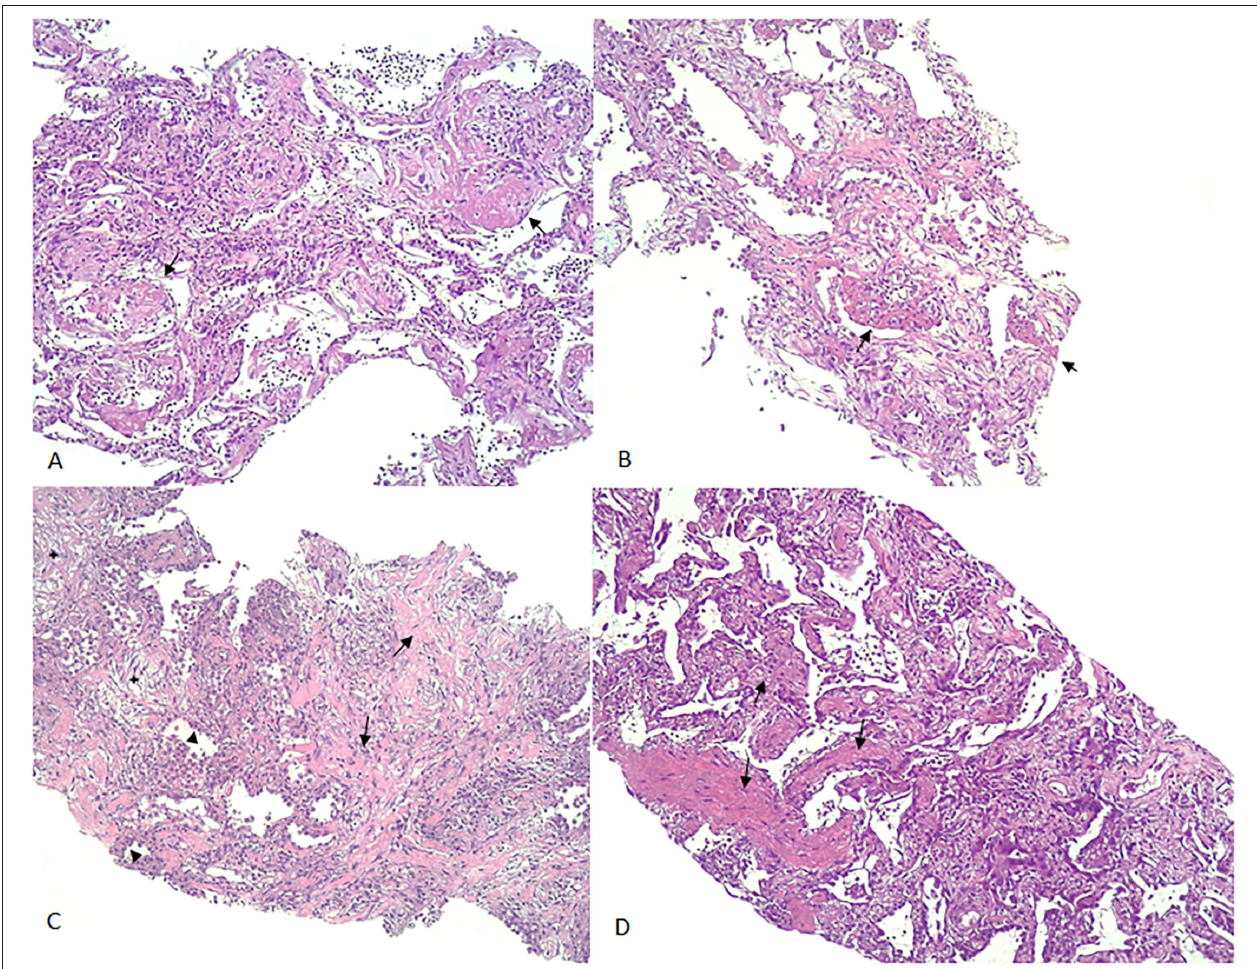
FIGURE 2 | Examples of CNB. (A) : AFOP-like DAD: (arrows: deposition of fibrin plugs filling the alveolar space); (B) : AFOP-like organizing DAD (arrows: fibrin plugs deposited in the alveoli and focal organization changes in the interstitium); (C) : AFOP-like fibrotic DAD [focal organizational changes (star), interstitial deposition of collagen (arrow) accompanied by pneumocyte type II hyperplasia (arrowhead)]. (D) : Fibrotic DAD (arrows: thickening of the alveolar septa with mature collagen deposition in the interstitium). CNB, core needle biopsy; DAD, diffuse alveolar damage; AFOP, acute fibrinous organizing